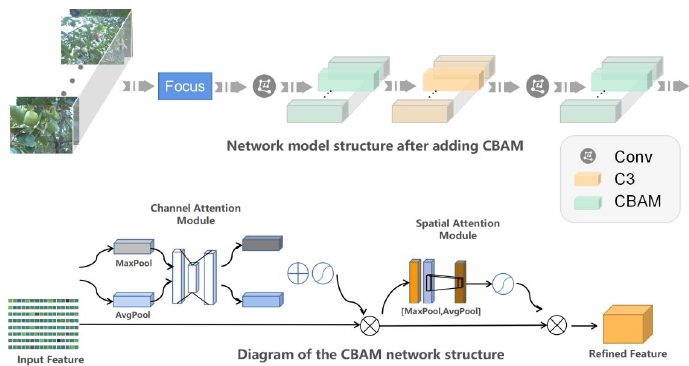
Figure 9. YOLOv5 with added CBAM post-structure and CBAM structure.